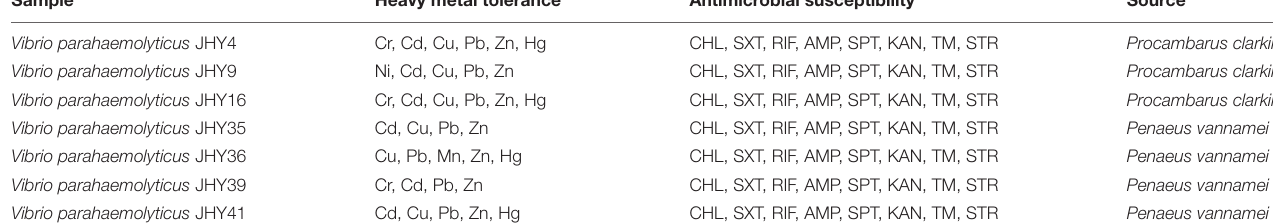
TABLE 4 | Susceptibility of V. parahaemolyticus harboring the SXT/R391 family of integrative and conjugative elements to heavy metals and antibiotics. Sample